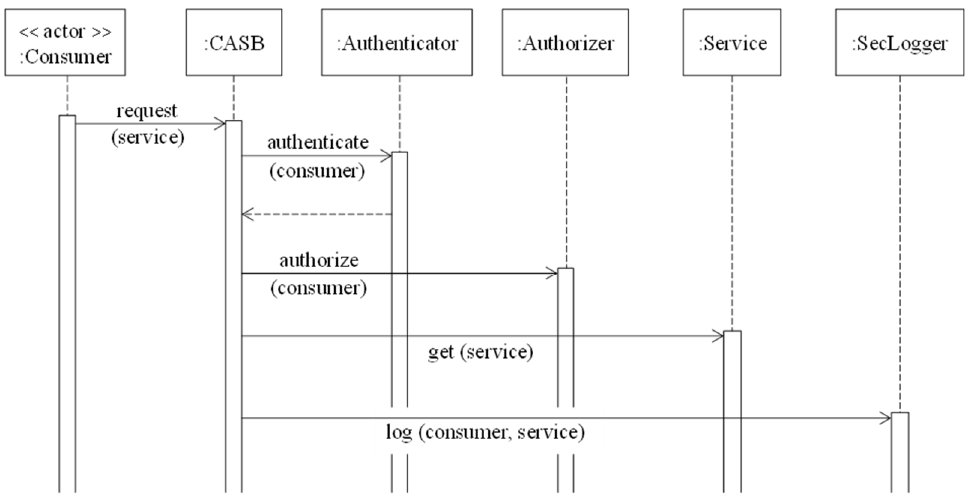
Figure 4. Sequence diagram for the use case “Access an application service”.